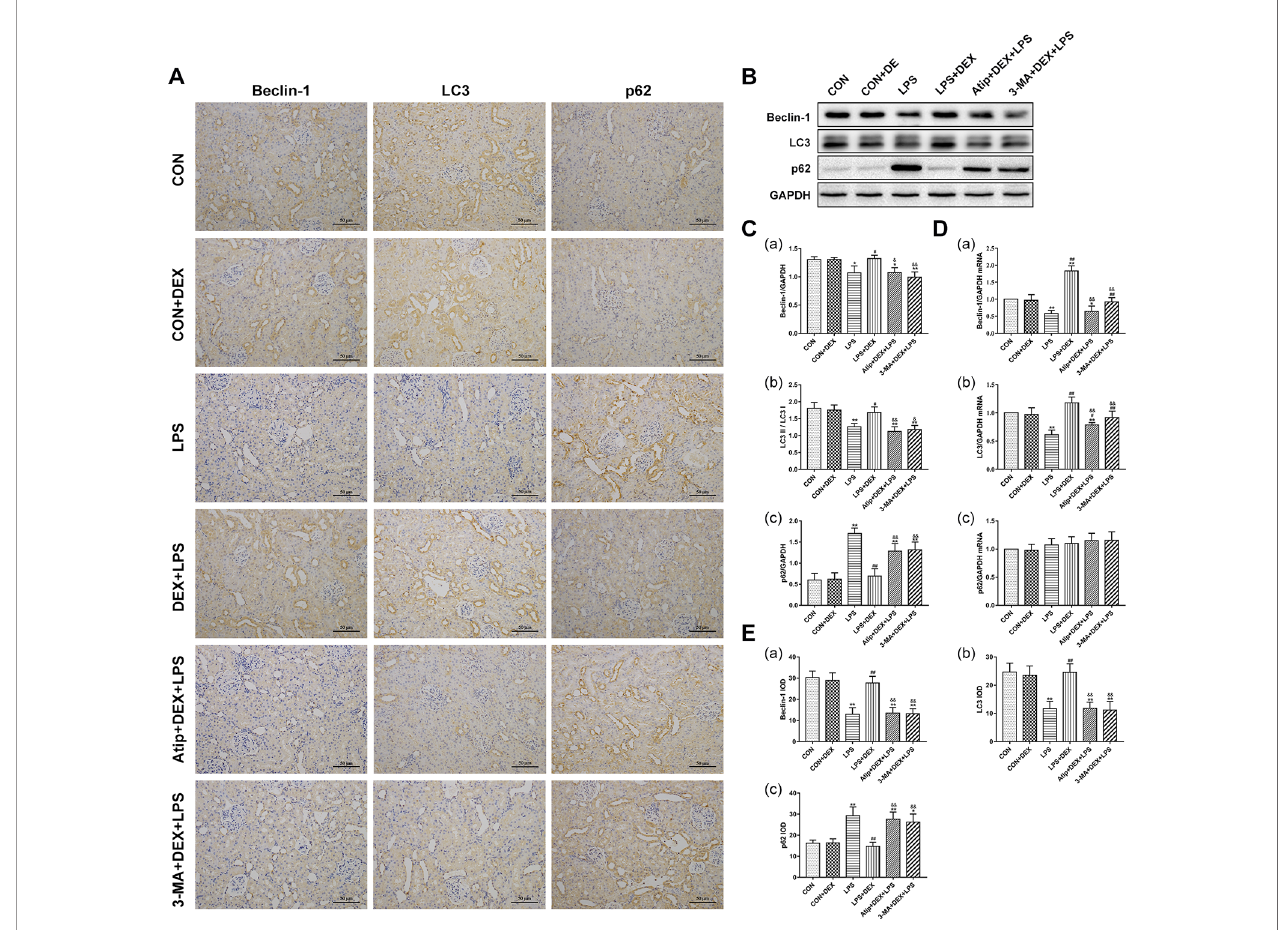
FIGURE 6 | Effects of DEX treatment on autophagy. (A) Representative images of Beclin-1 IHC, LC3 IHC, and p62 IHC. (B) Representative blots of Beclin-1, LC3, and p62. (C) Representative blots densitometry of Beclin-1 (a), LC3 (b), and p62 (c). (D) The expression of Beclin-1 (a), LC3 (b), and p62 (c)mRNA in renal tissues. (E) The quantitative analysis of Beclin-1 IHC (a), LC3 IHC (b), and p62 IHC (c) in kidney. Data are expressed as mean ± SEM (n = 6). *p < 0.05, **p < 0.01 versus CON group. #p < 0.05, ##p < 0.01 versus LPS group. &p < 0.05, &&p < 0.01 versus DEX + LPS